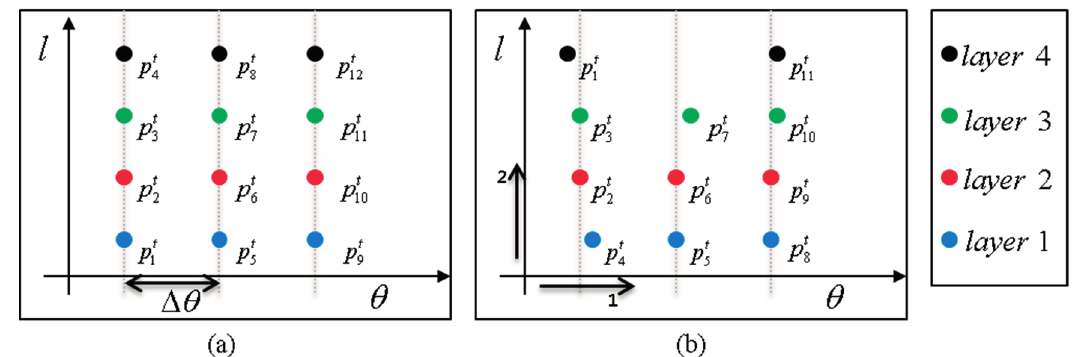
Figure 5. Scan points of the multi-layer laser scanner on the θ - l plane. ( a ) ideal output ( b ) actual